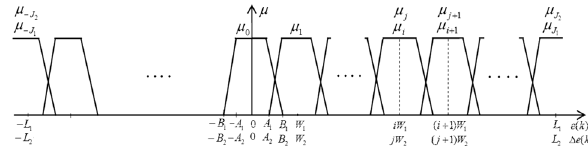
Fig. 11 Membership functions for multiple input fuzzy sets with 𝜃 1 = 𝜃 2 =